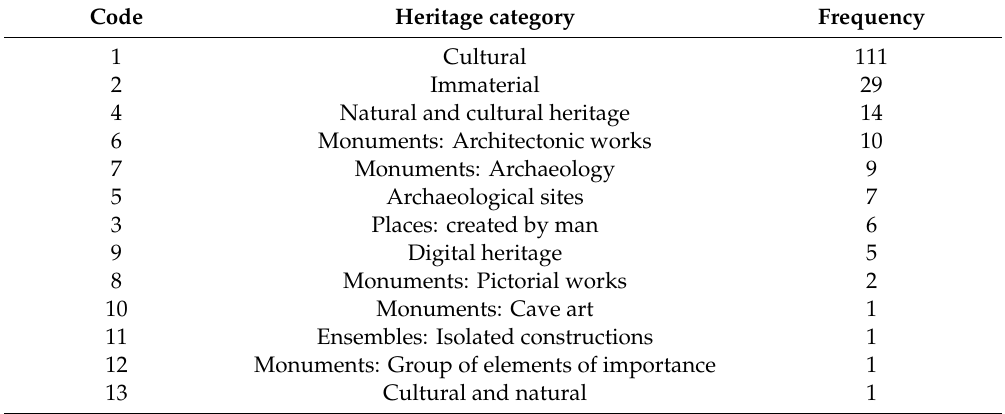
Table 4. Frequencies obtained according to heritage